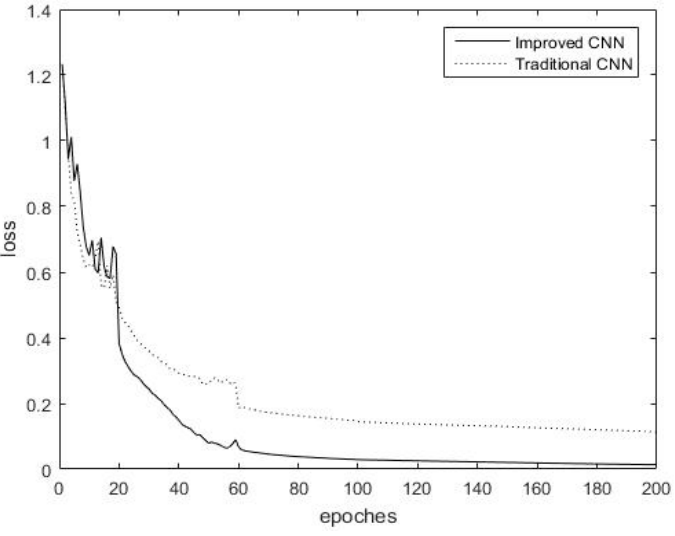
Figure 8. Training error of traditional CNN and maximum overlap pooling CNN iteration in the Indian Pines dataset.